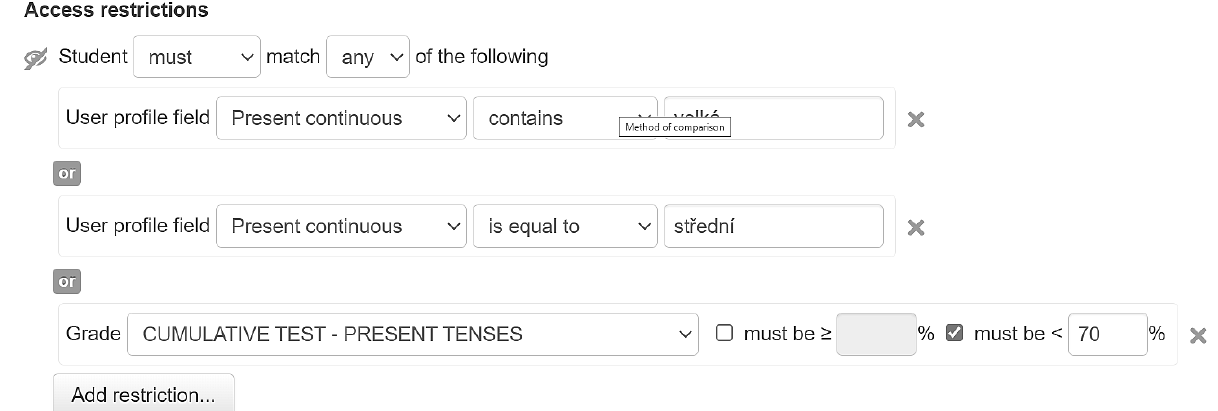
Table 2. A general structure of the e-course.